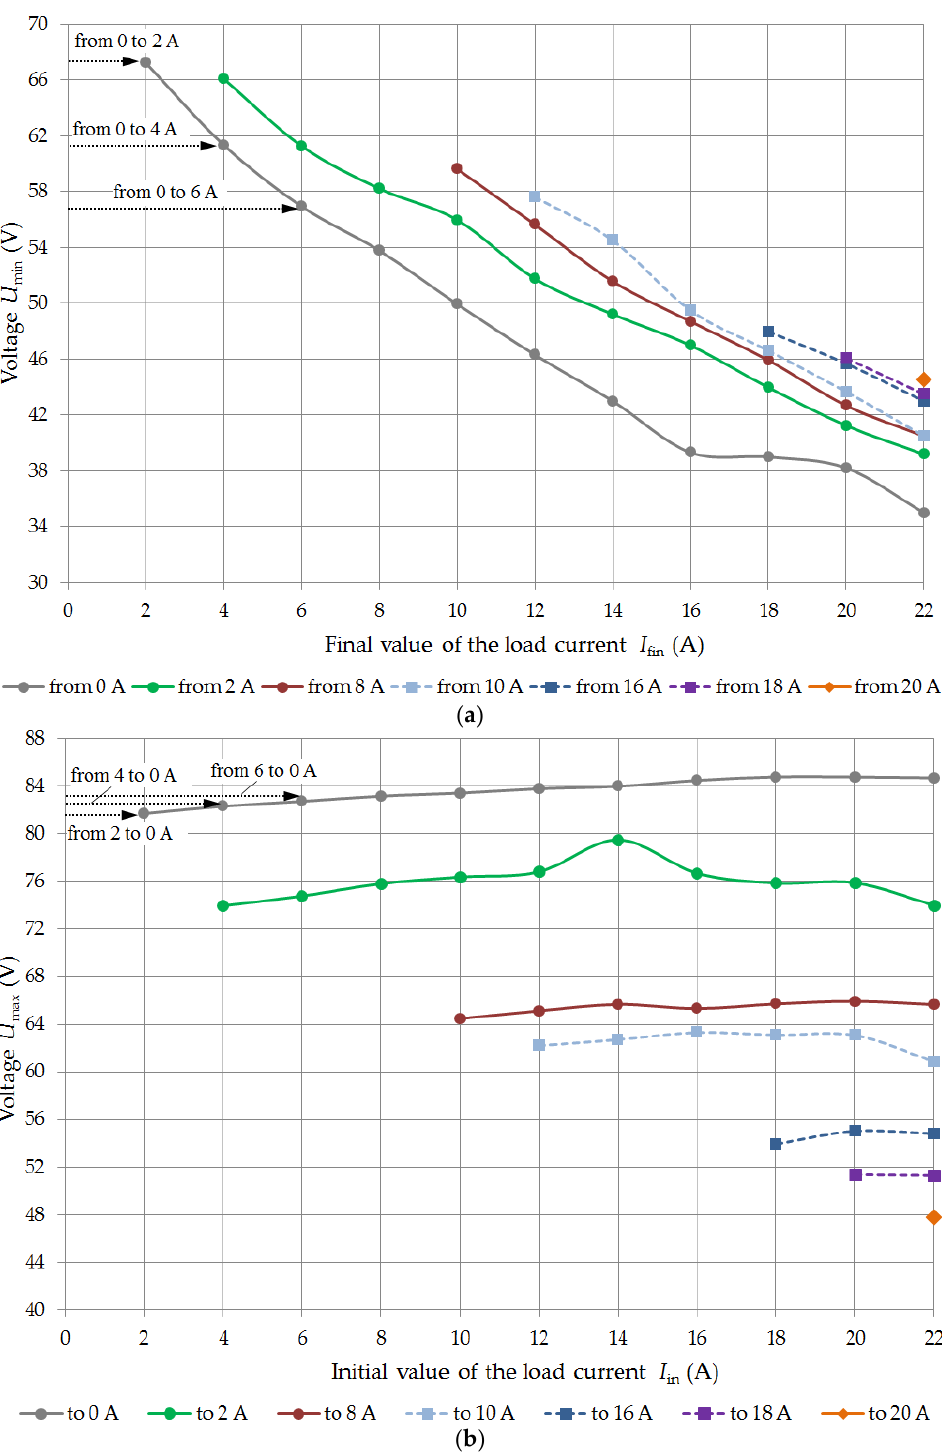
Figure 14. Dependencies of PEMFC characteristics under dynamic load increase: ( а ) U min on I fin ; ( b ) U max on I in .